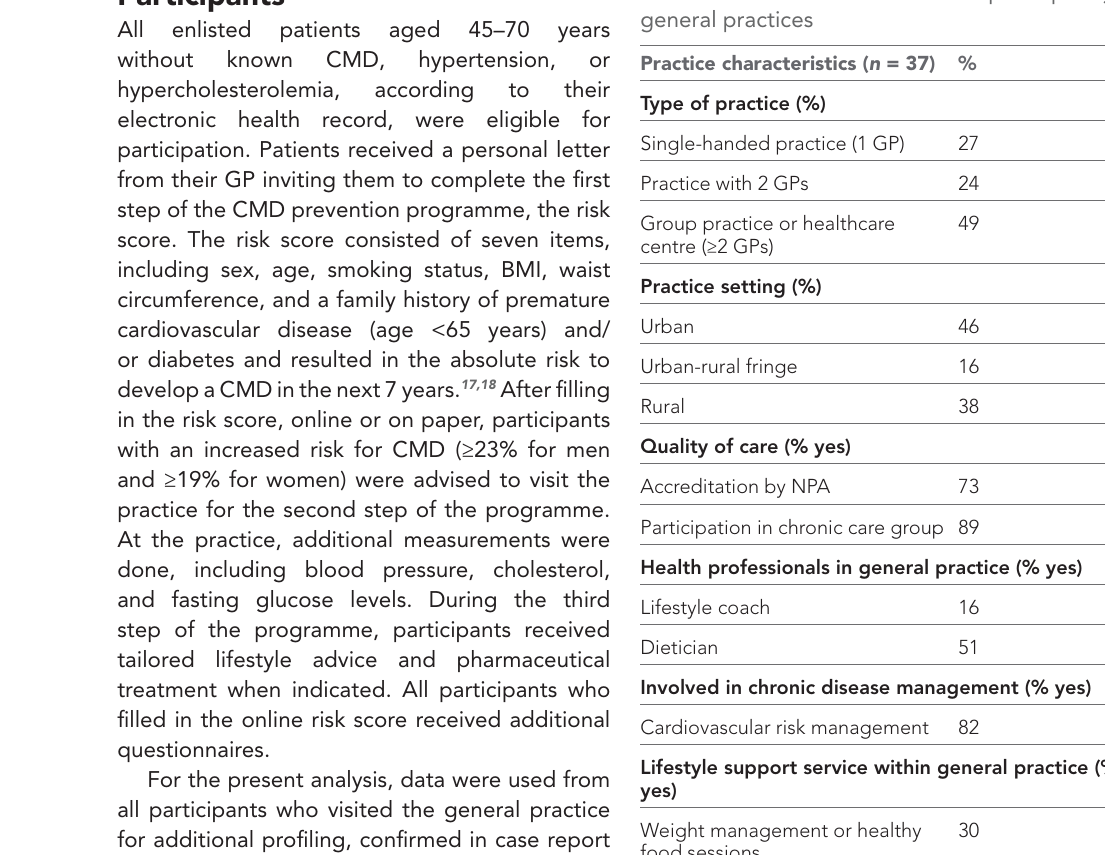
Table 1 Baseline characteristics of